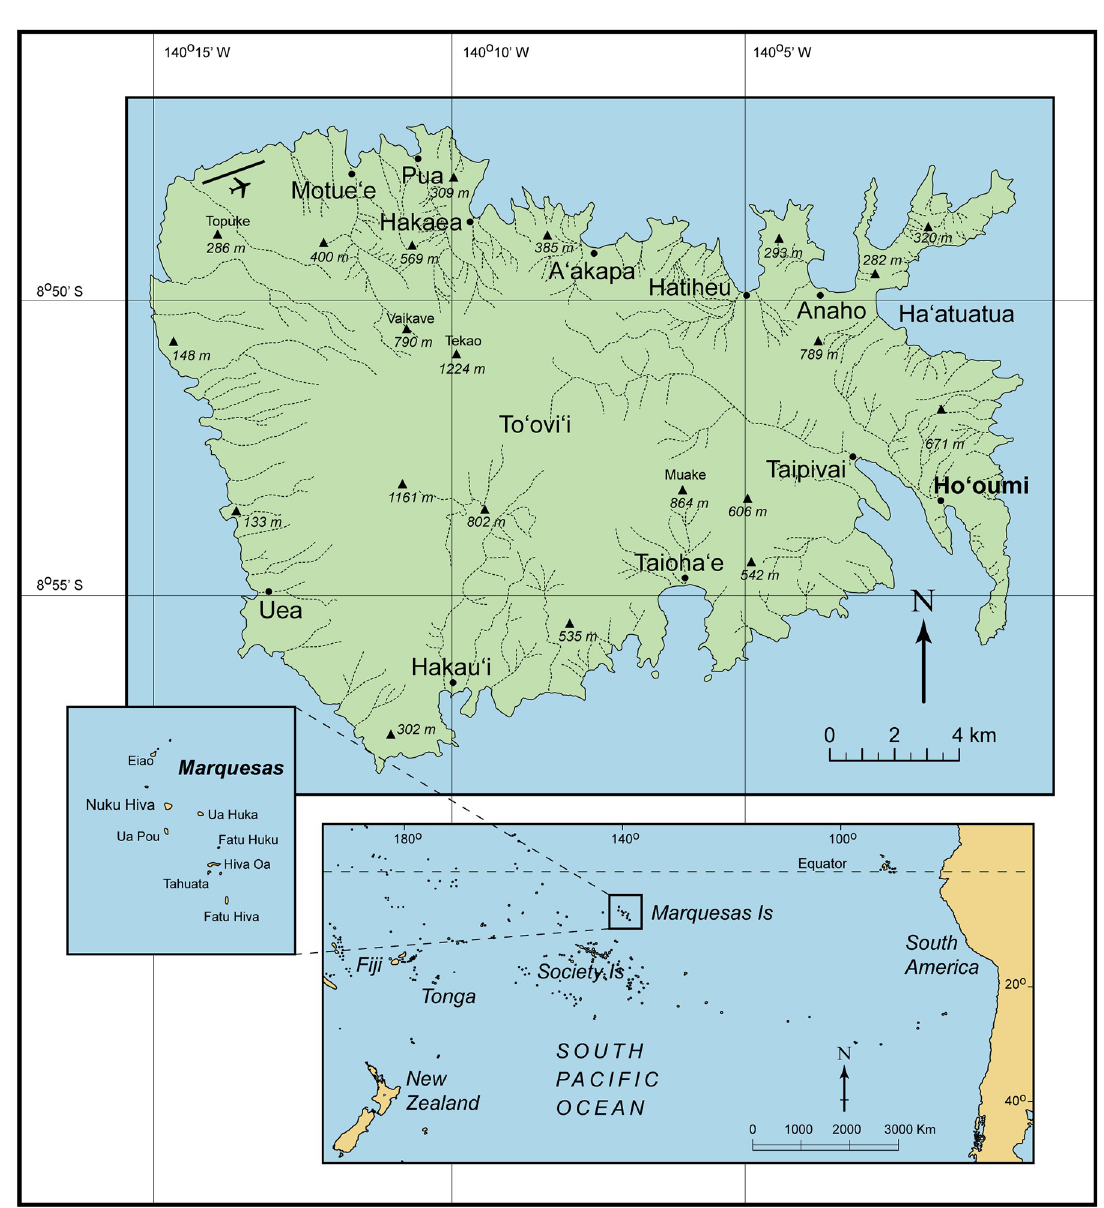
Fig 1. The island of Nuku Hiva, Marquesas Islands, East Polynesia. Ho‘oumi Valley is located on the southeastern coast, adjacent to the large valley of Taipivai.